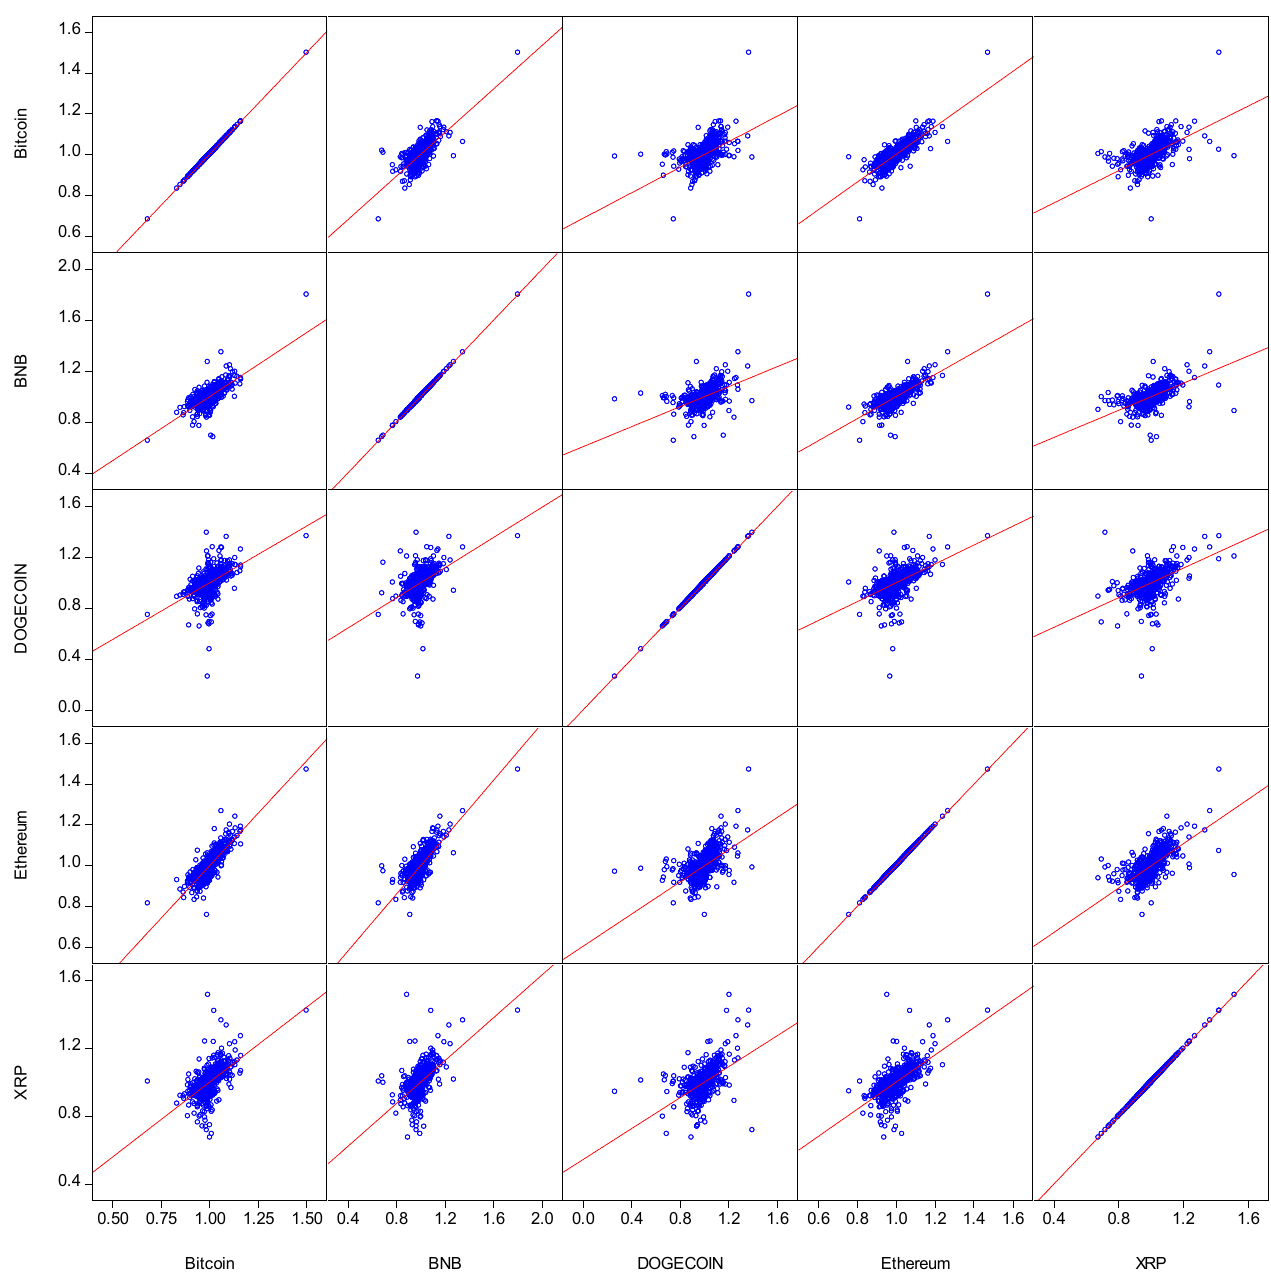
Figure 3. Correlation across the returns in cryptocurrencies with fitted regression line (authors’